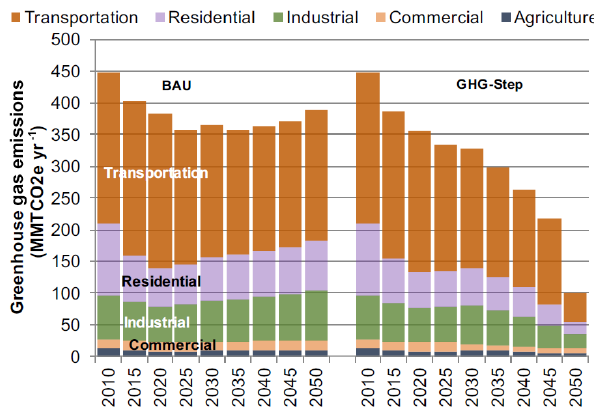
Figure 1. Greenhouse gas emissions in California under the BAU and GHG-Step